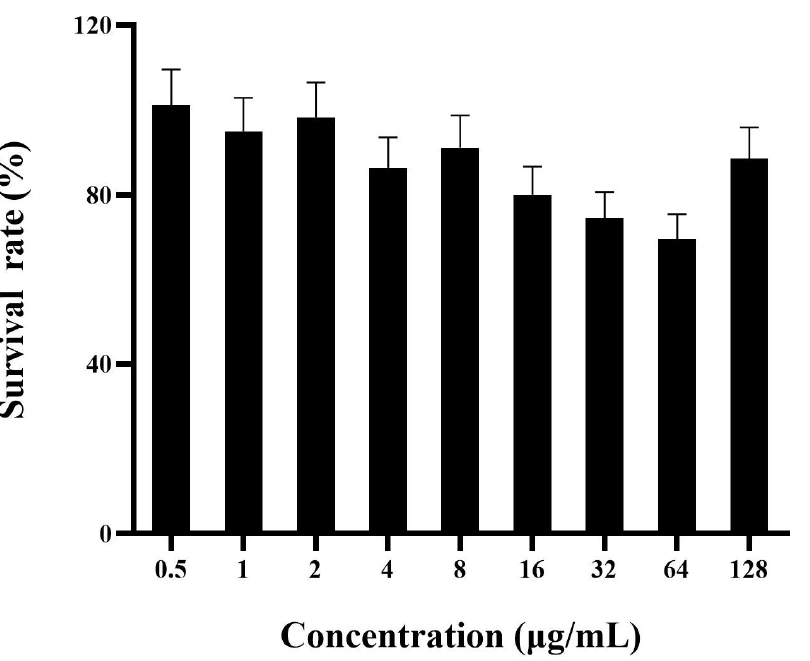
Figure 7. Cytotoxicity of FNZ against RAW264.7 cells. The results are given as the mean ± SD ( n = 3).